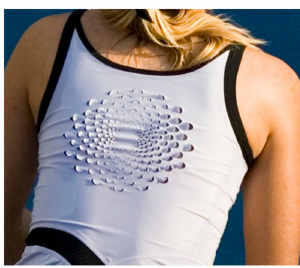
Figure 6. Detail of Nike Micro React sports wear garment active double cloth system in damp conditions. Source: Getty